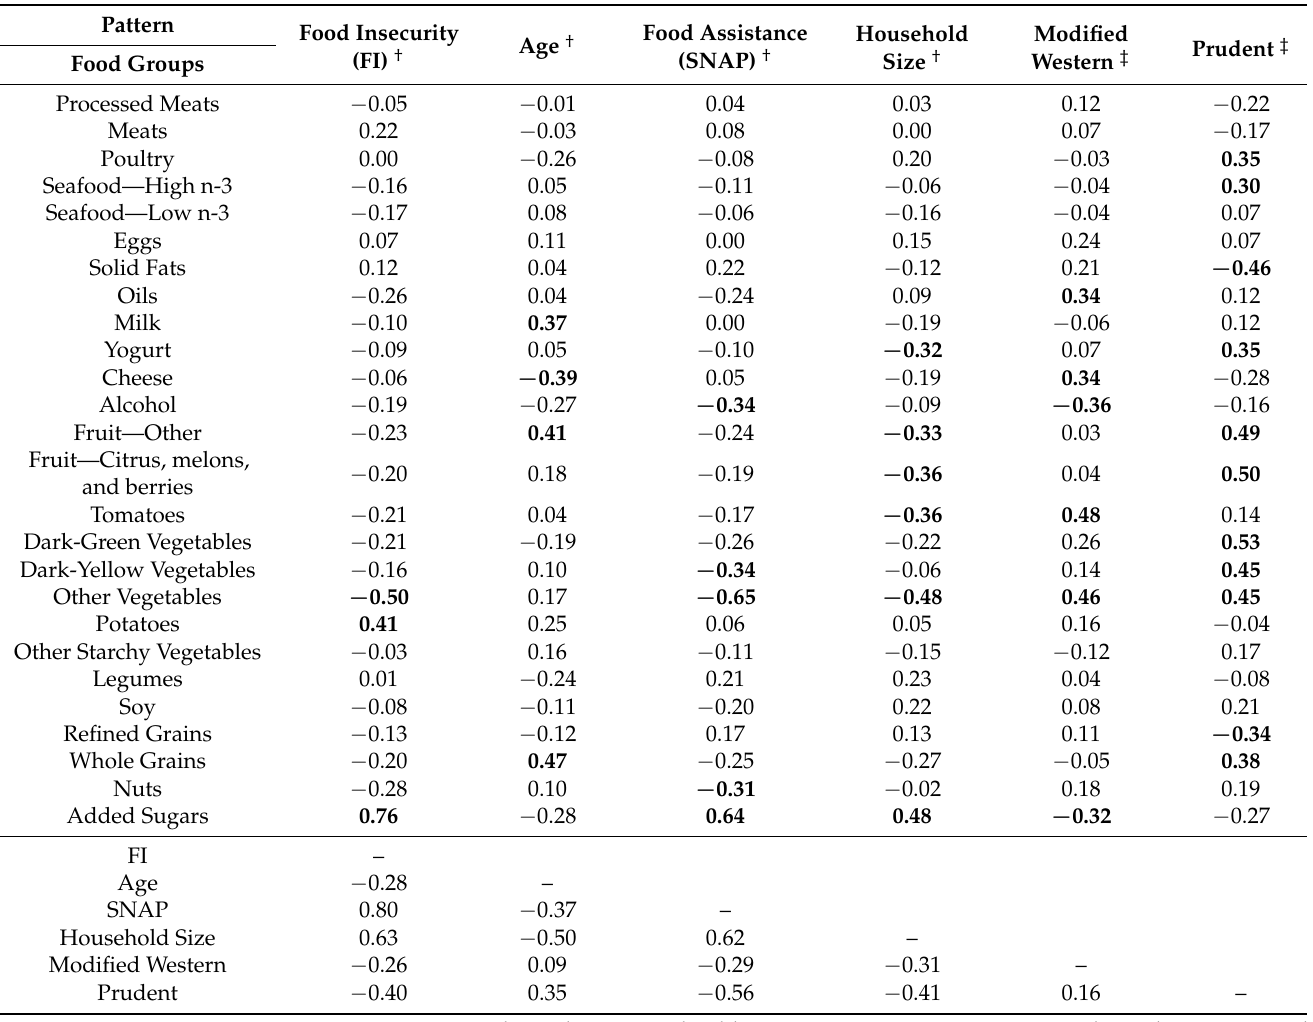
Table 2. Pearson correlation coefficients matrix amongst each of the derived patterns (extracted using either penalized logistic regression or principal components analysis) and the food groups used in the analysis. A lower triangular Pearson correlation matrix is appended, showing the correlations between the extracted dietary patterns. This analysis was performed on subsample A (Figure 1), an analytical subsample of cancer survivors ( n =